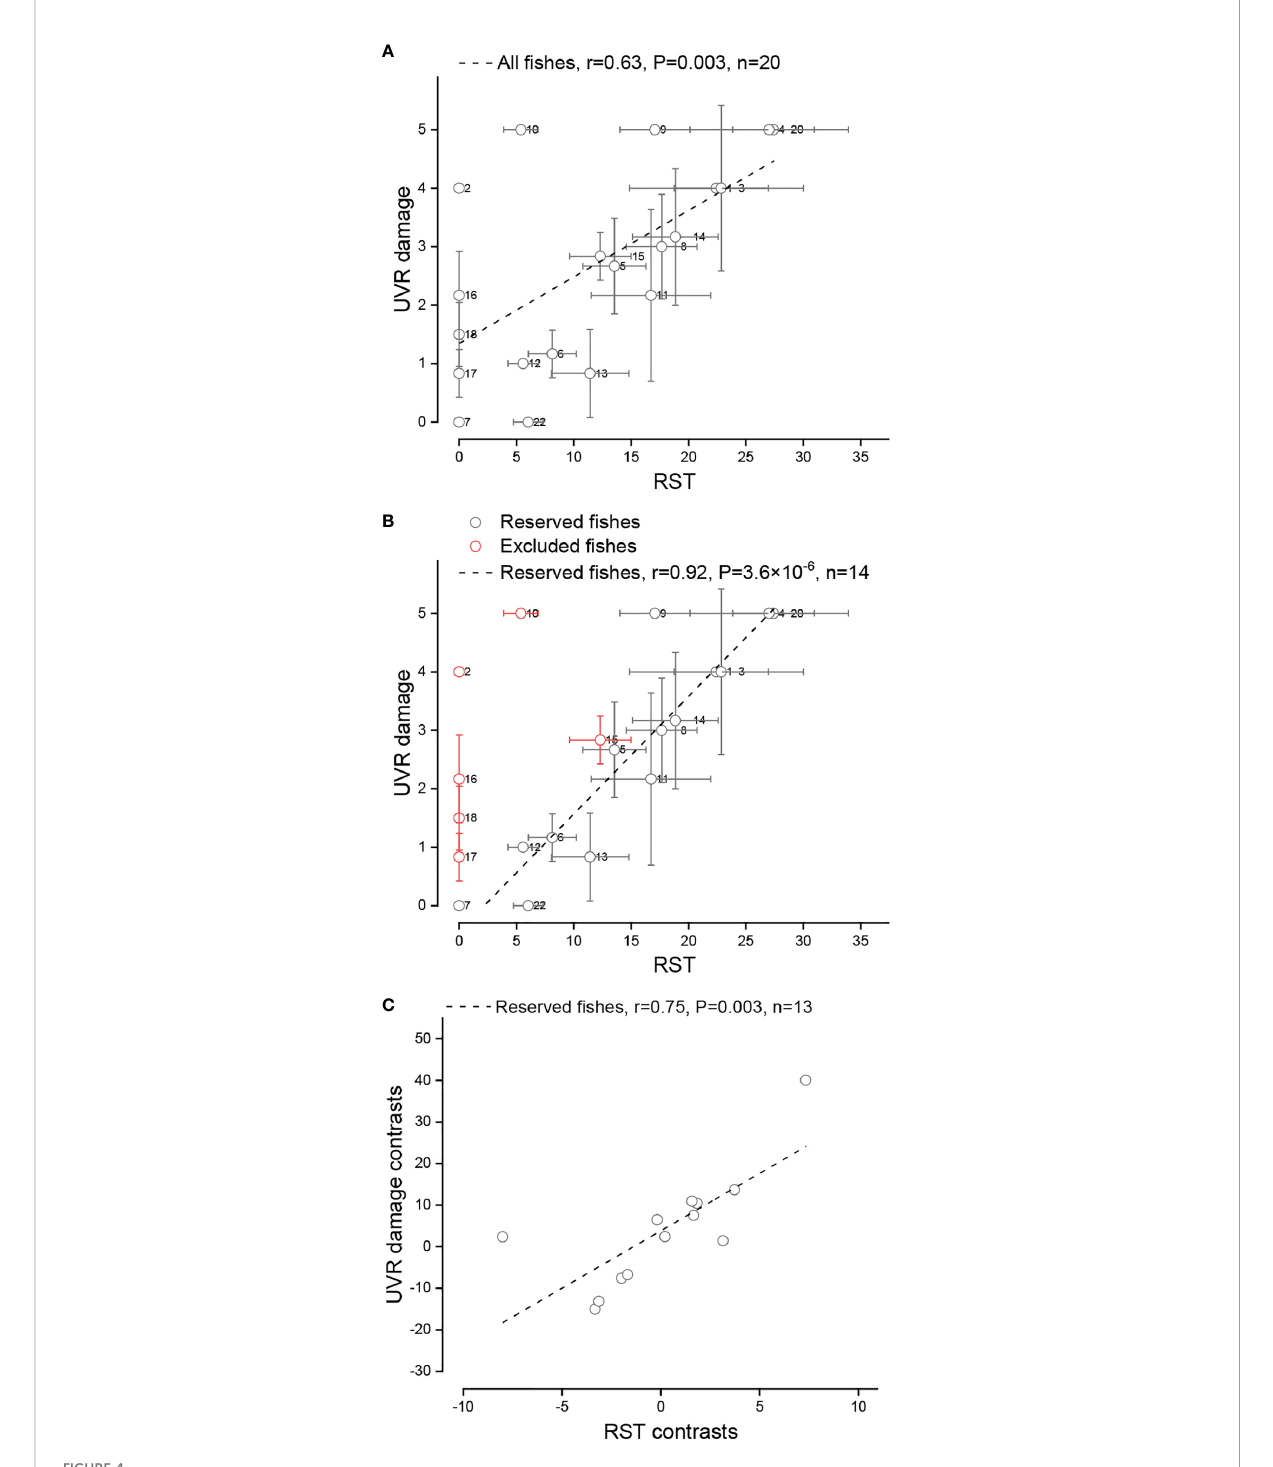
FIGURE 4 Relationship between the relative scale thickness (RST) and UVR damage of experimental fi shes. (A) Traditional correlation between the RST and UVR damage in all fi shes. (B) Traditional correlation between the RST and UVR damage in reserved fi shes. (C) Correlation between the RST and UVR damage in reserved fi shes as measured by PIC analysis. The circle and whiskers indicate the mean ± SD. A data point will be lost in PIC